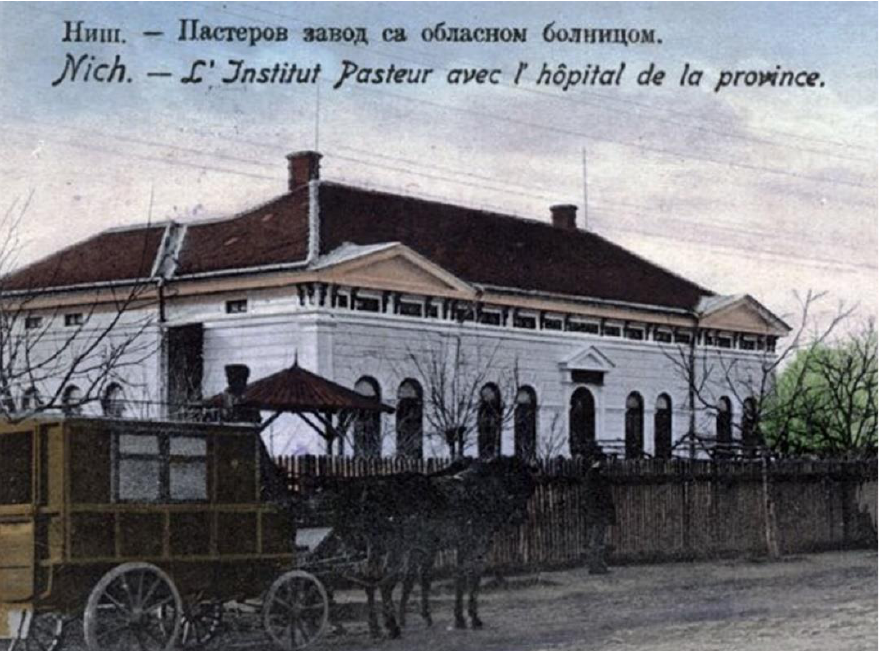
Figure 1. Pasteur Institute in Niš (picture made about 1910, originating from archive collection of Museum of Health Culture in Niš, and taken from https://sr.wikipedia.org/sr-ec/Пастеров_завод_у_Нишу , accessed on 23 December 2021).